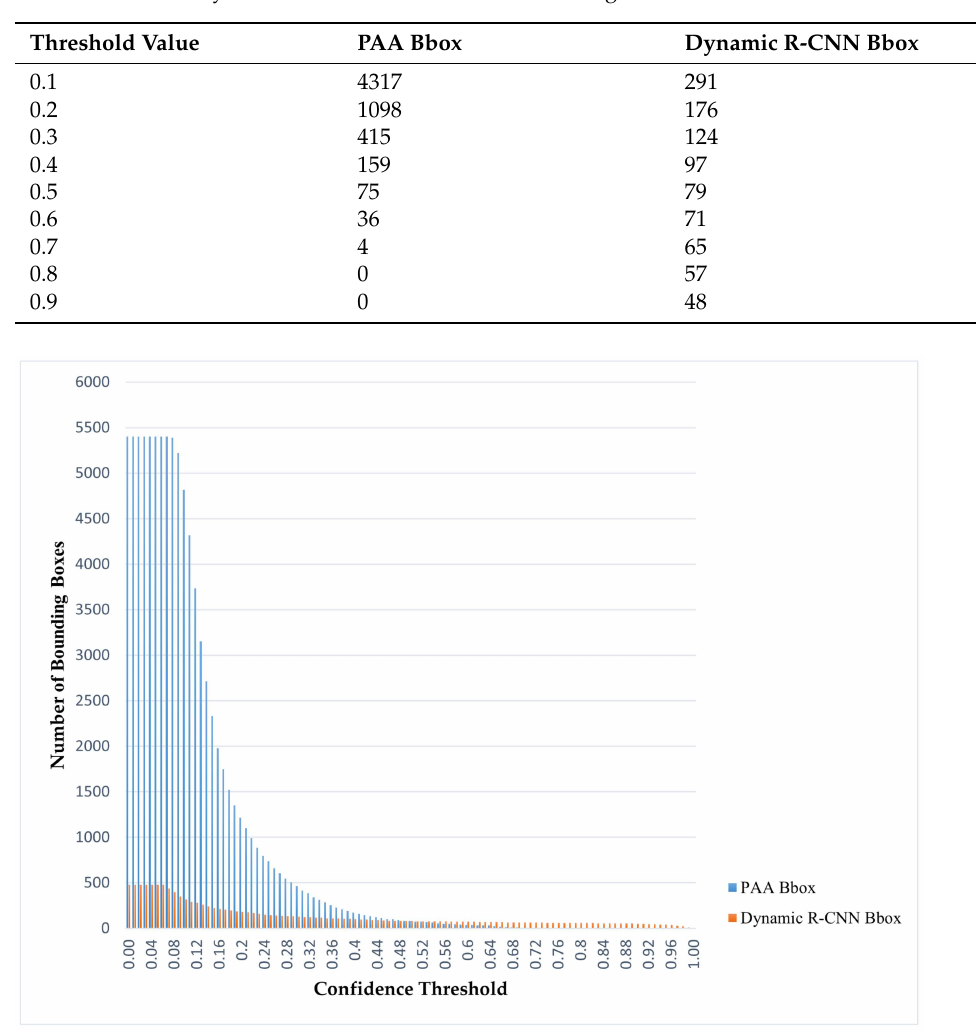
Figure 5. PAA and Dynamic R-CNN bbox numbers according to different threshold values. FSAF, PAA, RetinaNet and RetinaNet-based models (SABL, Libra, RegNet) were used as single-stage models, and Dynamic R-CNN, Faster R-CNN and Faster